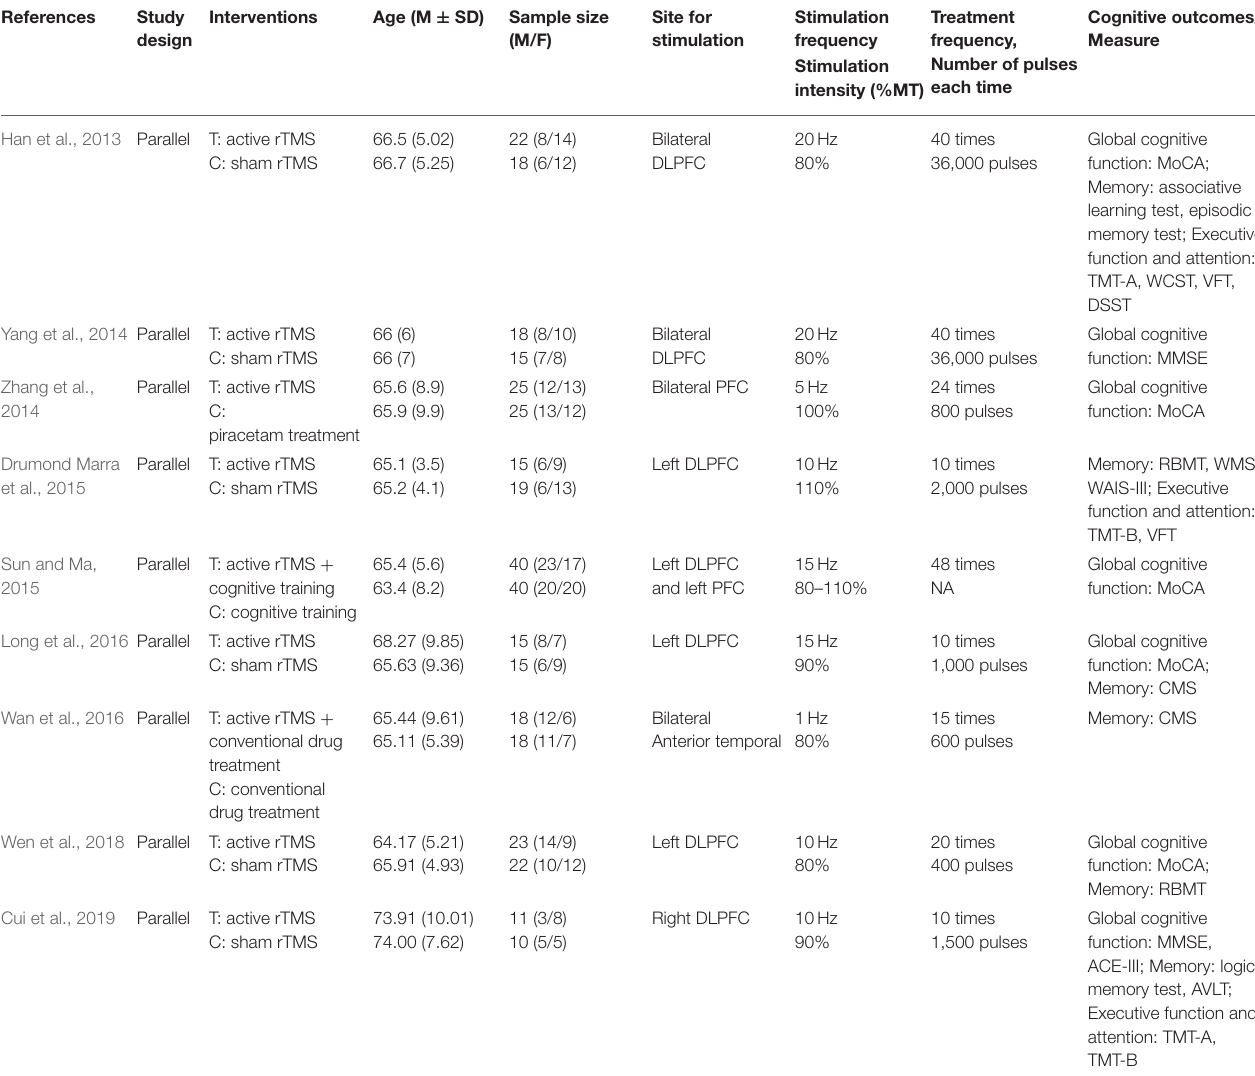
TABLE 1 | Characteristics of the nine included